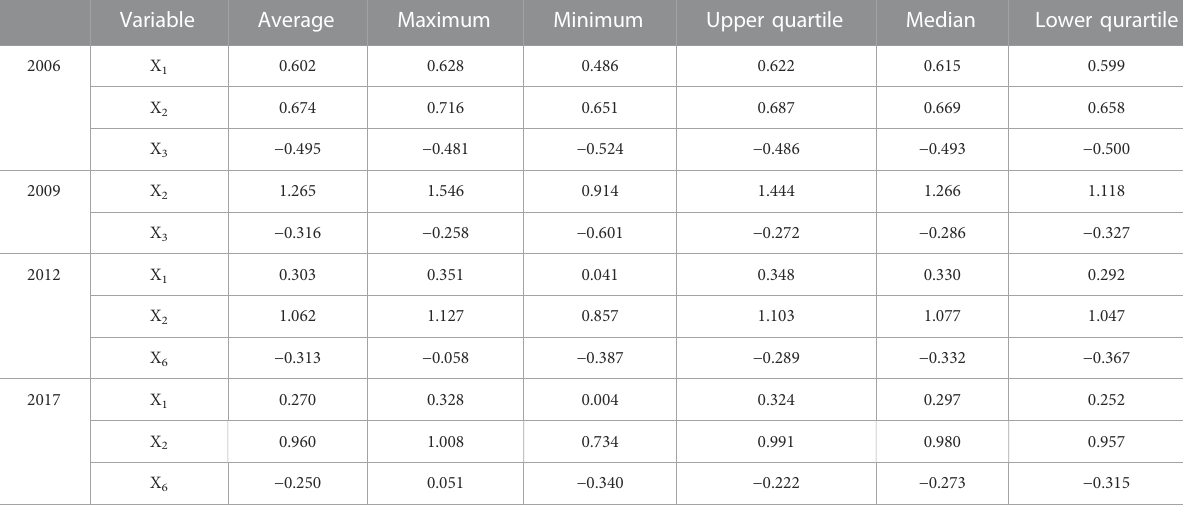
TABLE 5 Descriptive statistics of the regression coef fi cients in the GWR model (2006, 2009, 2012, and 2017).